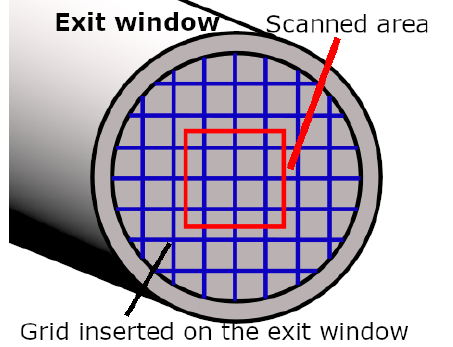
Fig. 3. Scheme of the metallic grid sample (G 1 and G 2 ) placed closely on the exit window. The beam scanned area is illustrated (red